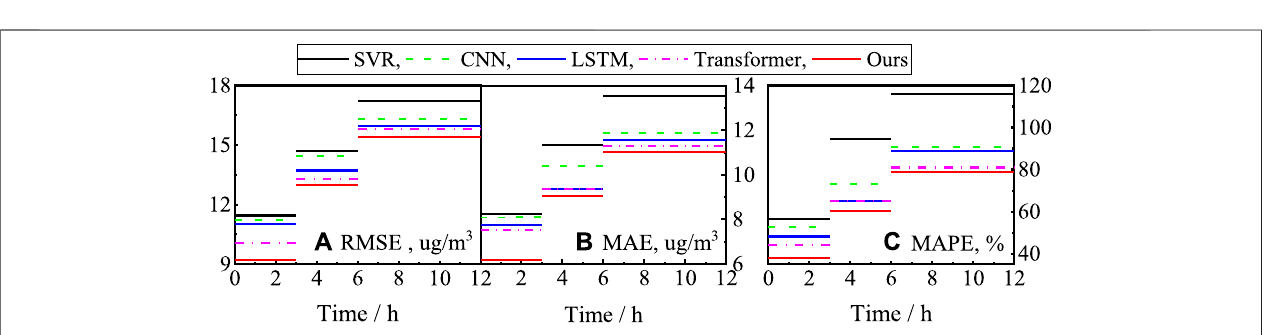
FIGURE 9 | Comparisons of different methods for multi-step prediction results for the next 12 h on Taizhou dataset.